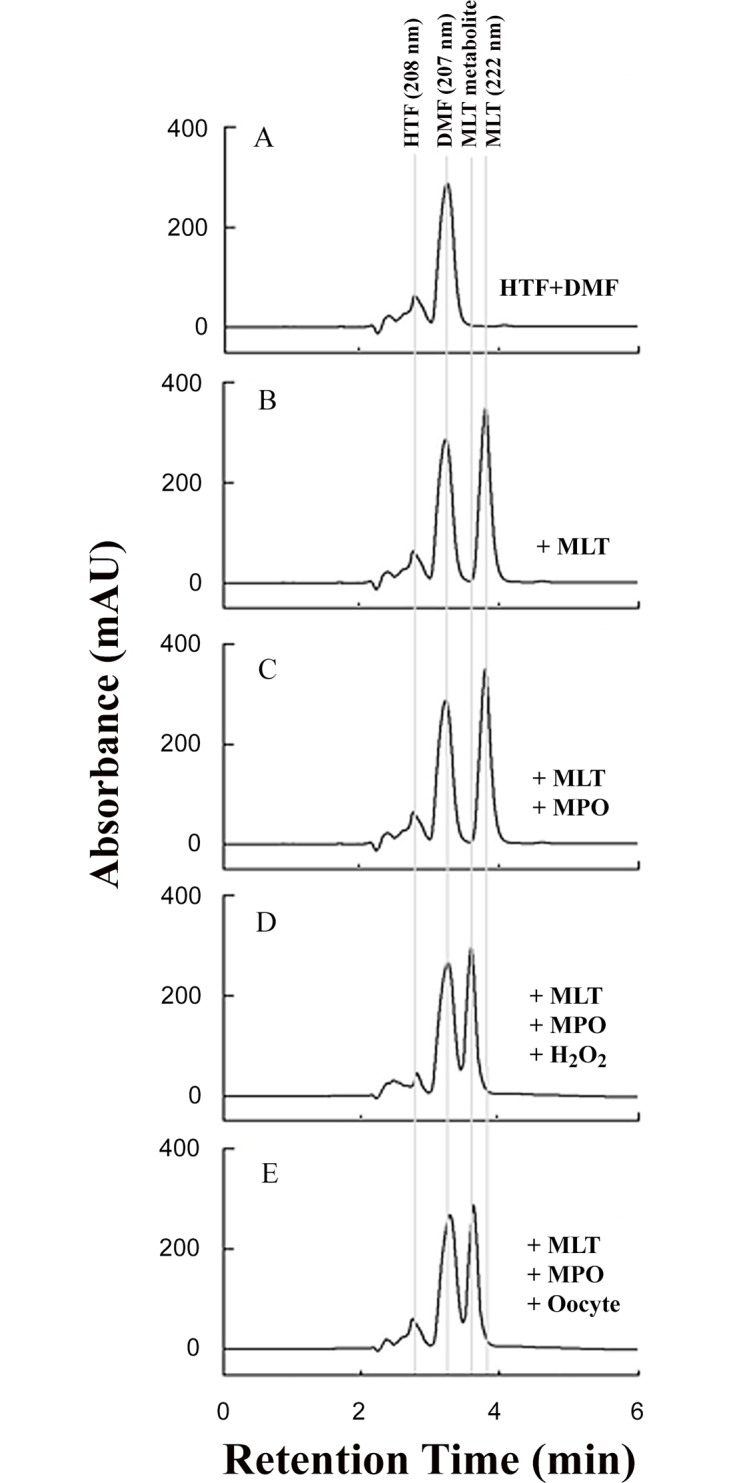
HPLC analysis shows evidence of the release of H2O2, which activates the catalytic function or MPO causing melatonin oxidation.A) HPLC trace DMF (elution time 3.31 min) and phosphate buffer (elution time 2.48 min). B) Trace for Melatonin (3.98 min) dissolved in DMF. C) Addition of MPO causes no significant change in melatonin peak intensity and/or retention time. D) Addition of exogenous H2O2 (sequential addition of 20 μM, total 200 μM) results in a significant shift in melatonin retention time elution time to a hydroxylated intermediate (3.71 min). E) Incubation of MPO and melatonin in the presence of oocytes produces similar peaks and retention time to exogenously added H2O2, signifying that H2O2 released from the oocytes reacts with MPO causing melatonin oxidation.